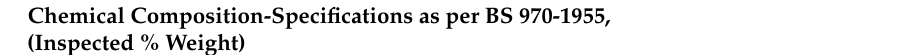
Table 1. Chemical composition and mechanical properties of steel grades.